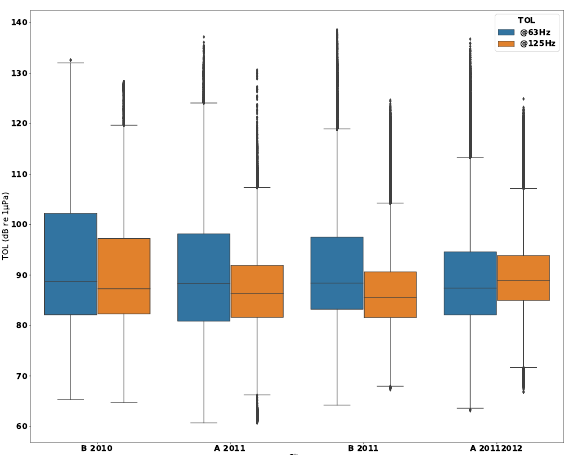
Figure 3. Boxplots representing the 63-Hz and 125-Hz centered Third octave band levels (TOL).